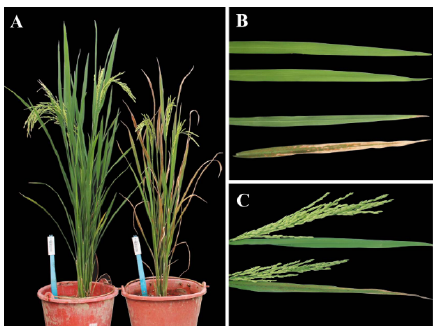
Figure 1. Comparison of phenotypes between the ospls1 mutant and wild type. ( A ) Plant morphological phenotype during the grain-filling period: left designates the wild type, and right designates the ospls1 mutant; and ( B ) flag leaves of the two genotypes. The upper two leaves represent the wild type at day 0 and 14 of grain-filling stage; the lower two leaves represent the ospls1 mutant at day 0 and 14 of grain-filling stage; ( C ) spikes with flag leaves on day 7 of the grain-filling stage; the upper indicates the wild type, and the lower indicates the ospls1 mutant.